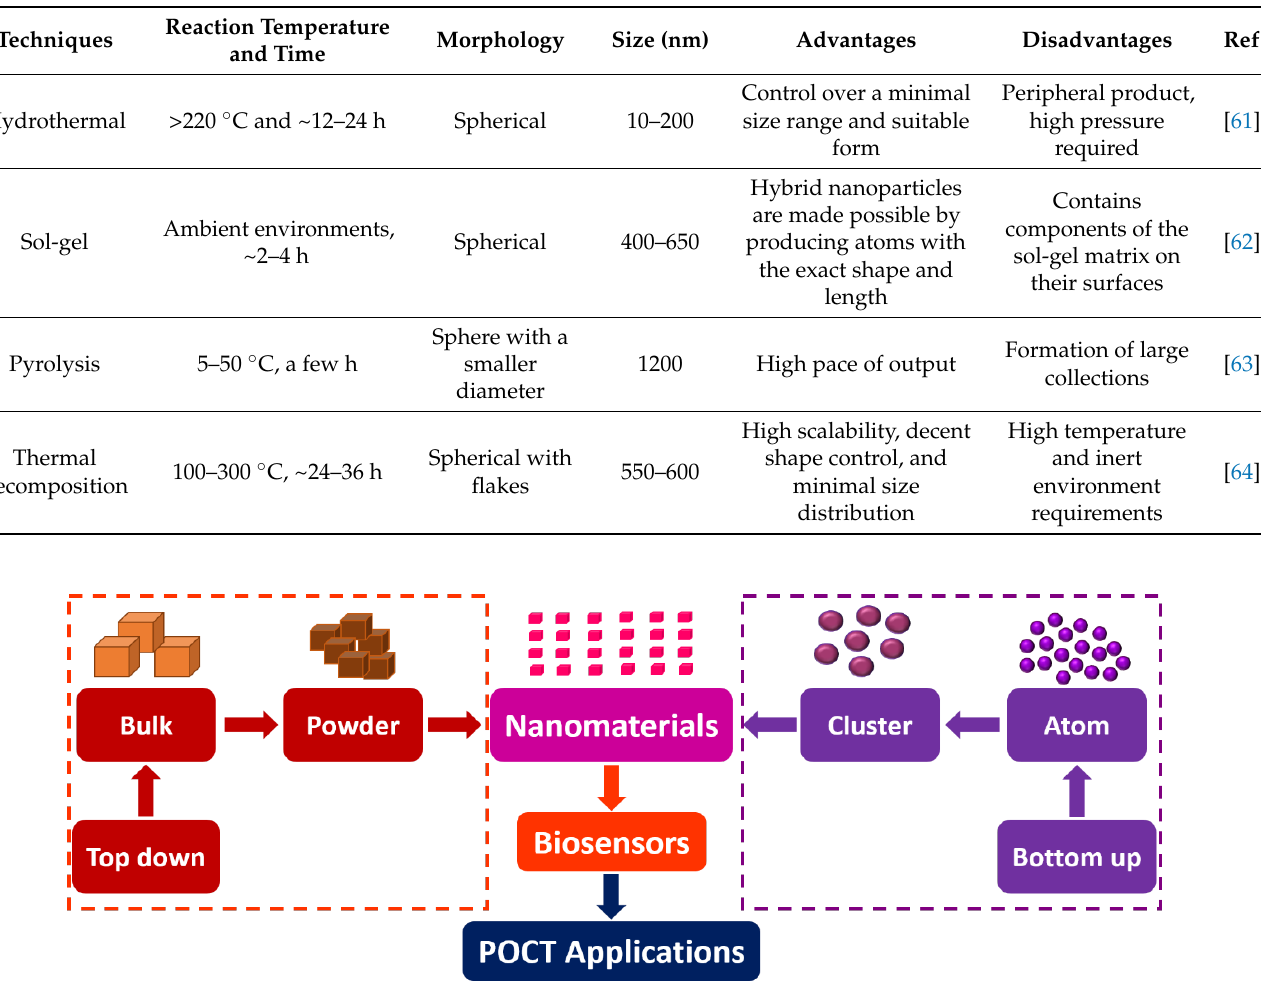
Table 1. Summarizes different methods of nanomaterials synthesis.